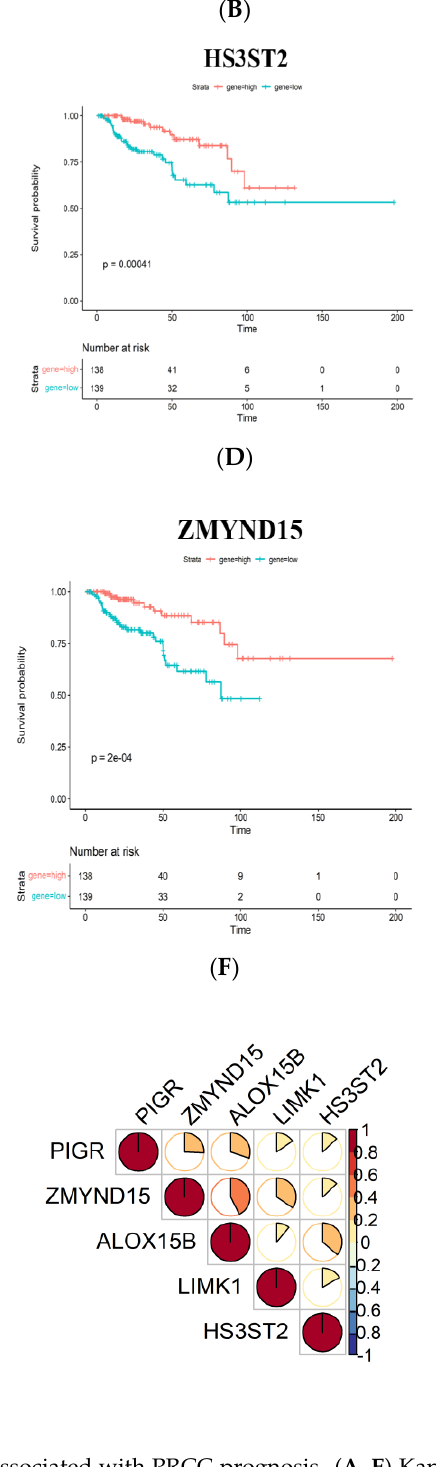
Figure 4. Identification of tumor antigens associated with PRCC prognosis. ( A – E ) Kaplan–Meier curves showing the overall survival probability of PRCC patients in groups with different expressions of ALOX15B ( A ), HS3ST2 ( B ), PIGR ( C ), ZMYND15 ( D ) and LIMK1 ( E ). ( F ) The expression correlations among the five genes.